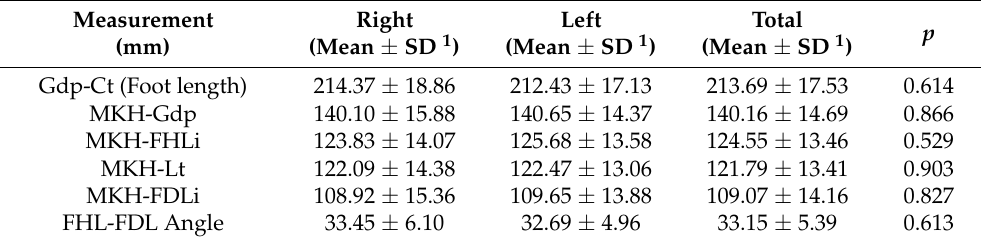
Table 1. Comparison of the left and right sides of the measured